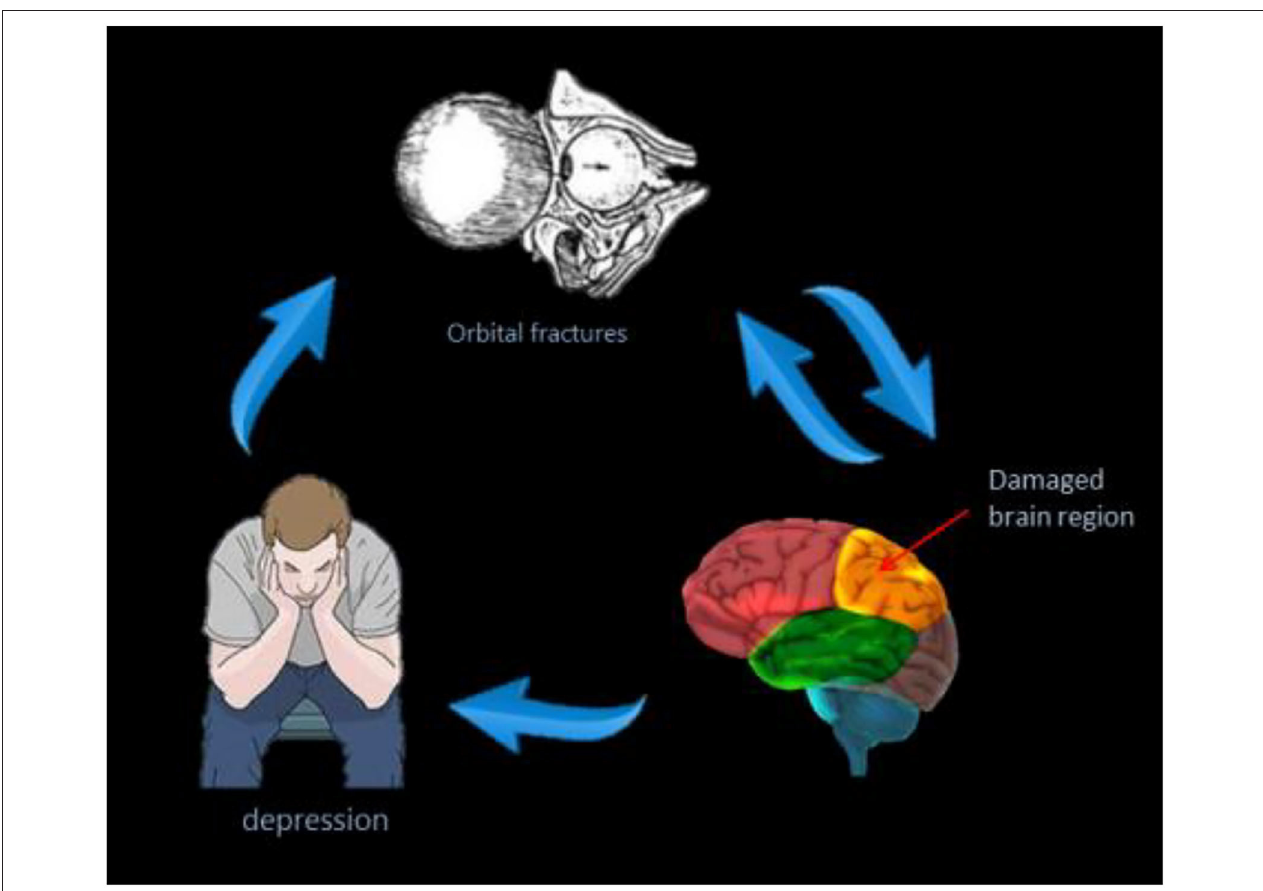
FIGURE 5 | The correlations between average fALFF signal values and clinical manifestation of patients with OF. The patients with OF have lower fALFF values, and they are more likely to develop depressive symptoms. OF, orbital